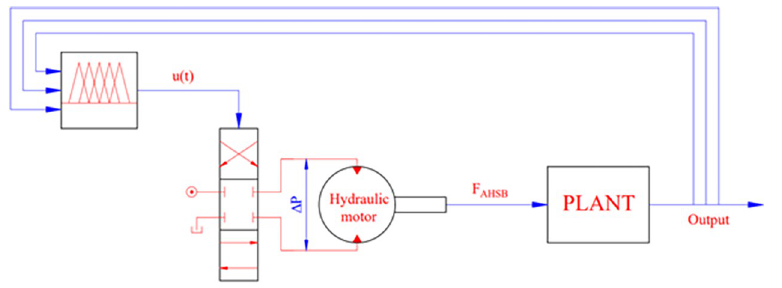
Fig 3. Schematic of the control